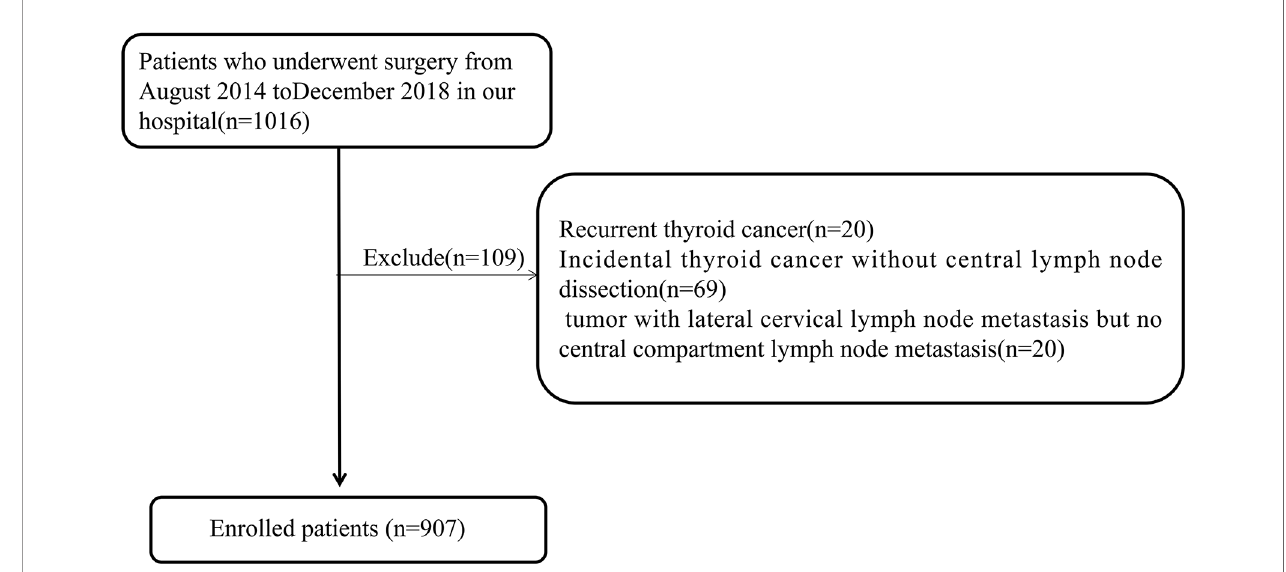
FIGURE 1 | The fl ow chart of the patients enrolled in this